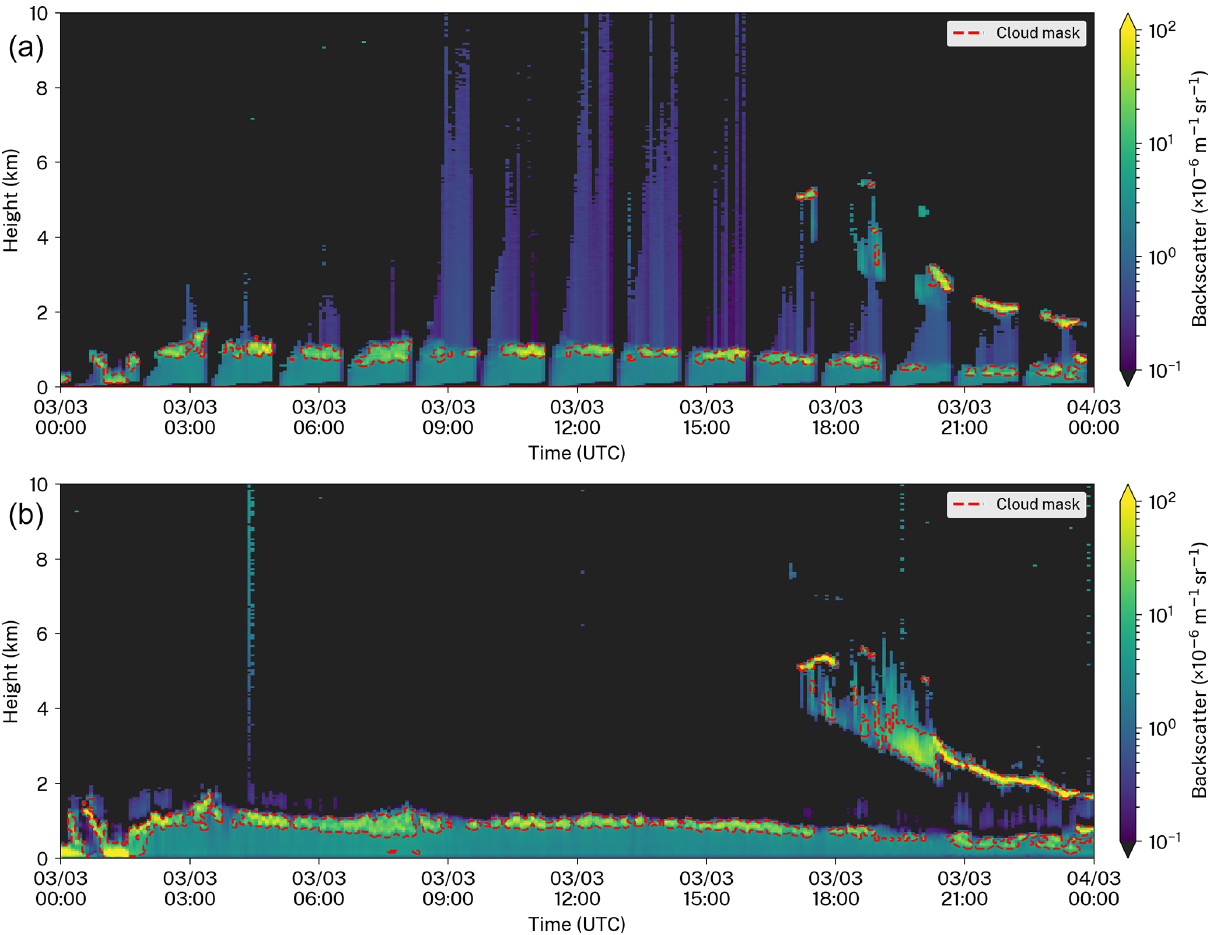
Figure 12. Automatically generated output plots from the ALCF tool showing backscatter ratios over 24h for 3 March 2018 for the MiniMPL data (a) and ceilometer data (b) . Cloud mask is overplotted as dashed red lines. The periodic structure in the MiniMPL occurs because it was scanning over a range of elevation angles and so would saturate at lower altitudes when measuring at lower elevations angles (larger air masses occurring closer to the